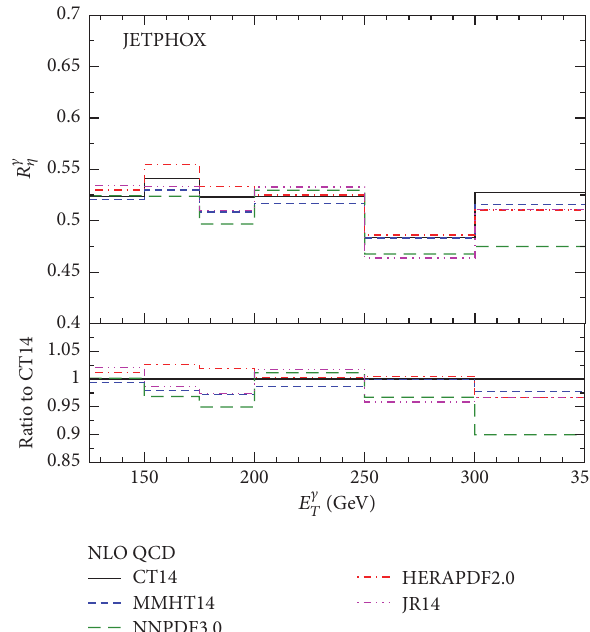
Figure 7: A comparison of the ratio of the NLO theoretical predictions for the differential cross section of the isolated prompt photon for the rapidity region 1.56 < |𝜂 𝛾 | < 2.37 to the same ones but for the rapidity region |𝜂 𝛾 | < 1.37 as a function of 𝐸 various NLO PDFs of CT14 [92] (black solid curve), MMHT14 [93] (blue dashed curve), NNPDF3.0 [94] (green long-dashed curve), HERAPDF2.0 [95] (red dotted-dashed curve), and JR14 [96] (pink dotted-dotted-dashed curve) at √𝑠 = 13 TeV in the kinematic range 125 < 𝐸 𝛾 < 350 GeV for |𝜂 𝛾 | < 2.37 excluding the region 1.37 < 𝑇 |𝜂 𝛾 | < 1.56 . Ratio to the central value of CT14 has been shown in the bottom